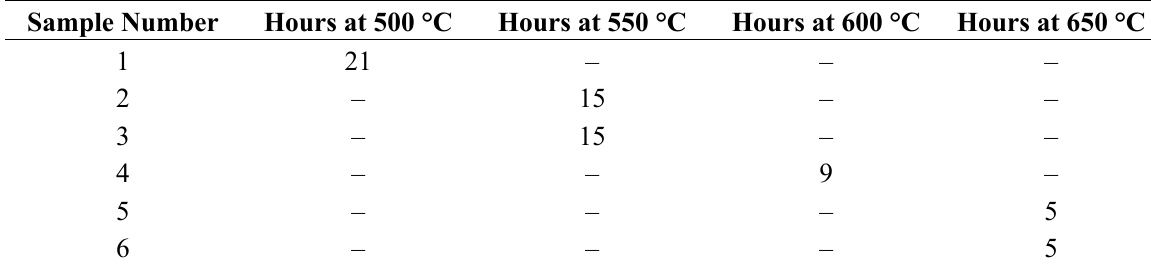
Table 1. The results of the tensile stress experiments performed every hour during annealing at varied temperatures. All of the samples were Cu-coated optical fibers, which were repeatedly stretched every hour. Each value represents the time of annealing, after which the sample